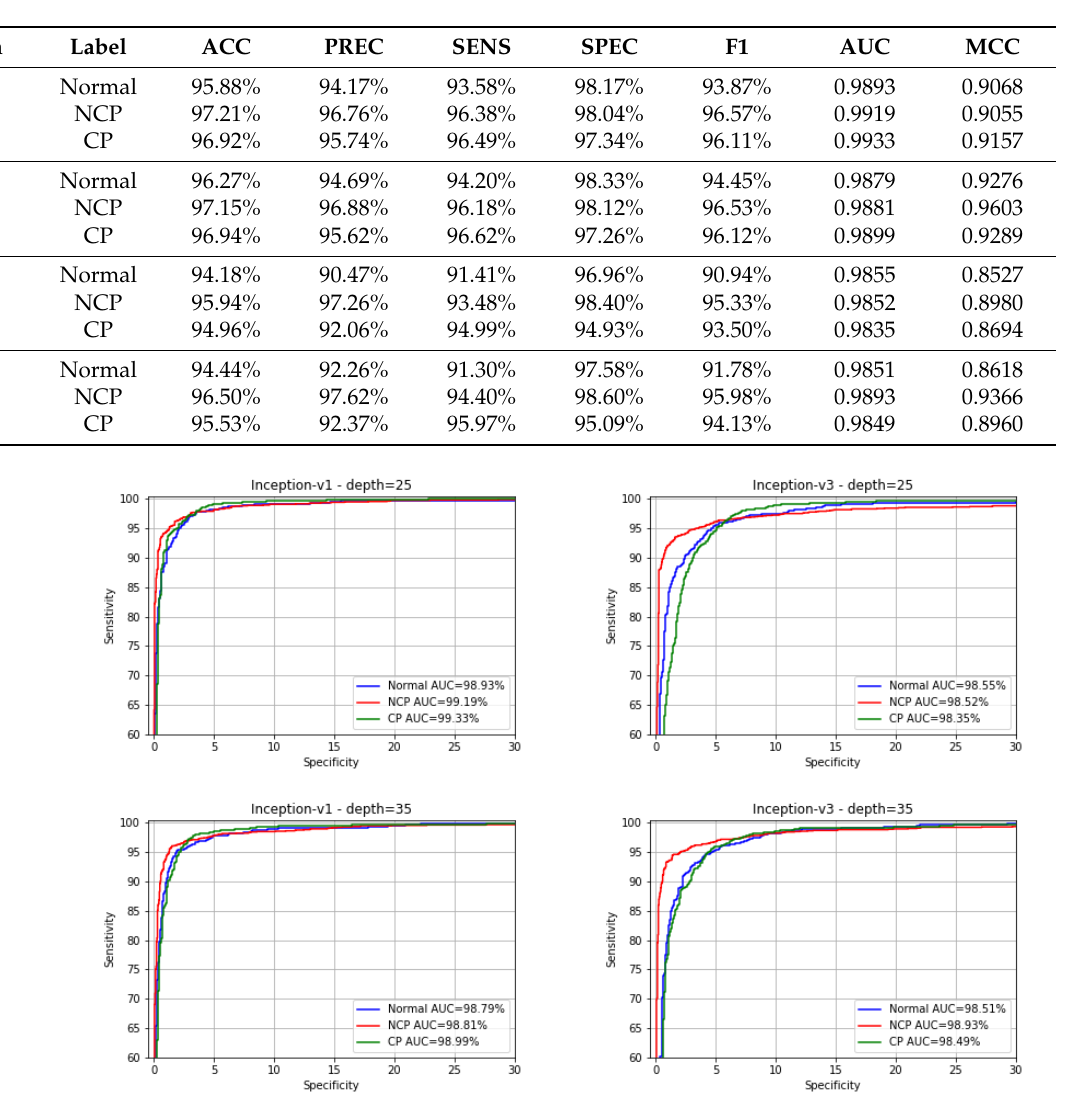
Table 6. Individual models—Class-Wise performances for Inception-V1 and Inception-V3 using 25 and 35 slices in terms of accuracy, precision, sensitivity, specificity, F1-score, Area Under the ROC Curve, and Matthews Correlation Coefficient.